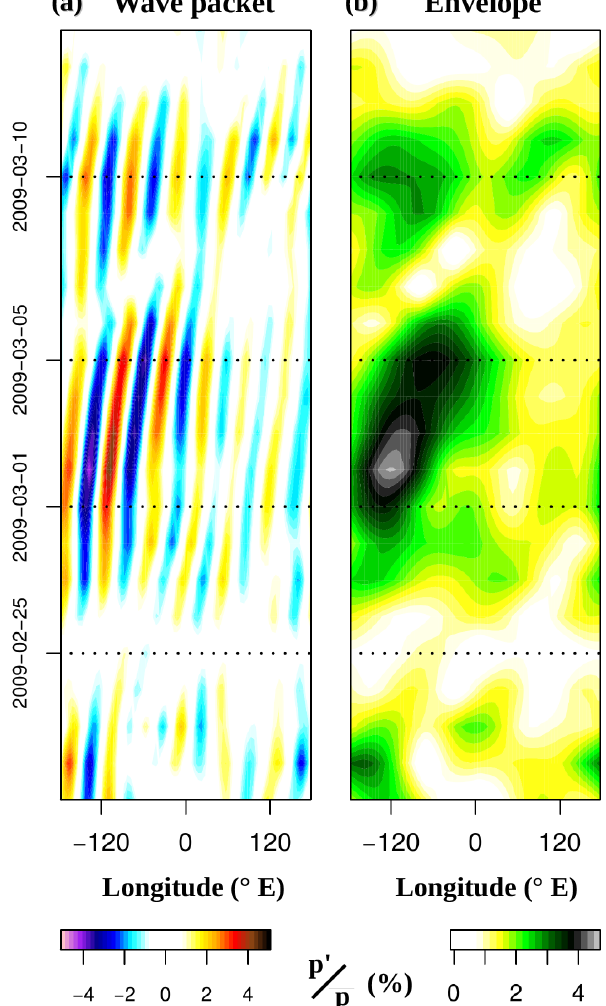
Figure 6. (a) Hovmöller diagram of RWP pressure anomalies (w5– 8) at zonal-mean tropopause level from the end of February to the beginning of March 2009, averaged for 40–60 ◦ N. (b) Correspond- ing envelope of the RWP